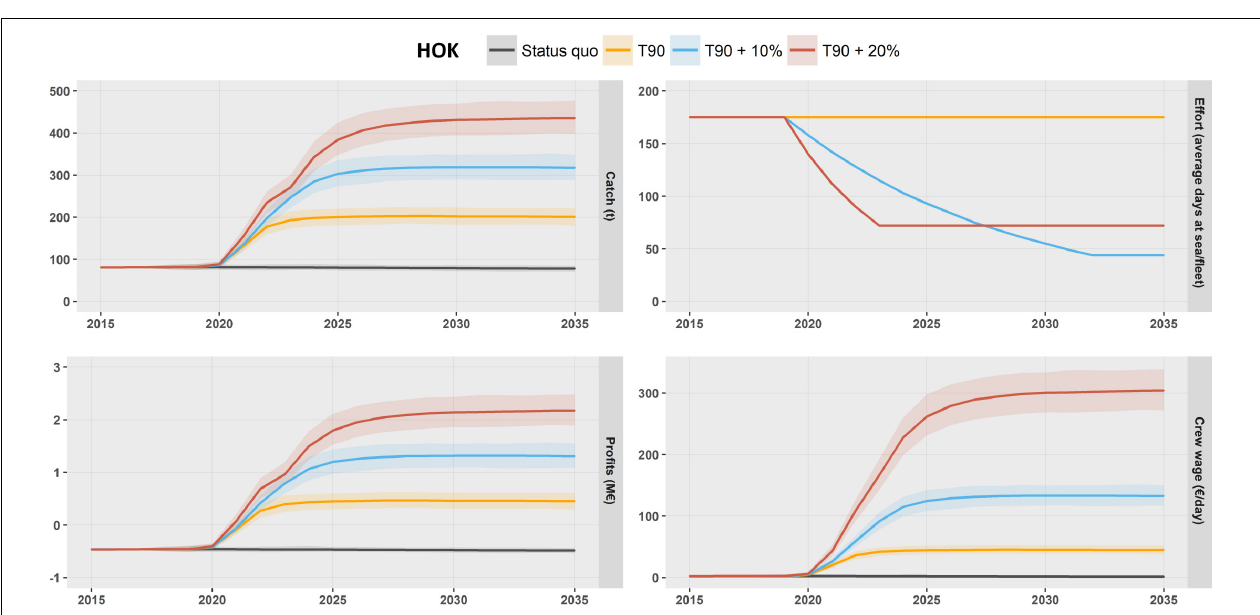
FIGURE 8 | Results of the bioeconomic model of catch (t), effort (average days at sea), profits (M€), and crew wage (€/day) for demersal longline fleet (HOK) under Scenario 0: status quo ; Scenario 3: selectivity change to T90; Scenario 4: selectivity change plus 10% annual reduction over 4 years; and Scenario 5: selectivity change plus 20% annual reduction over 4